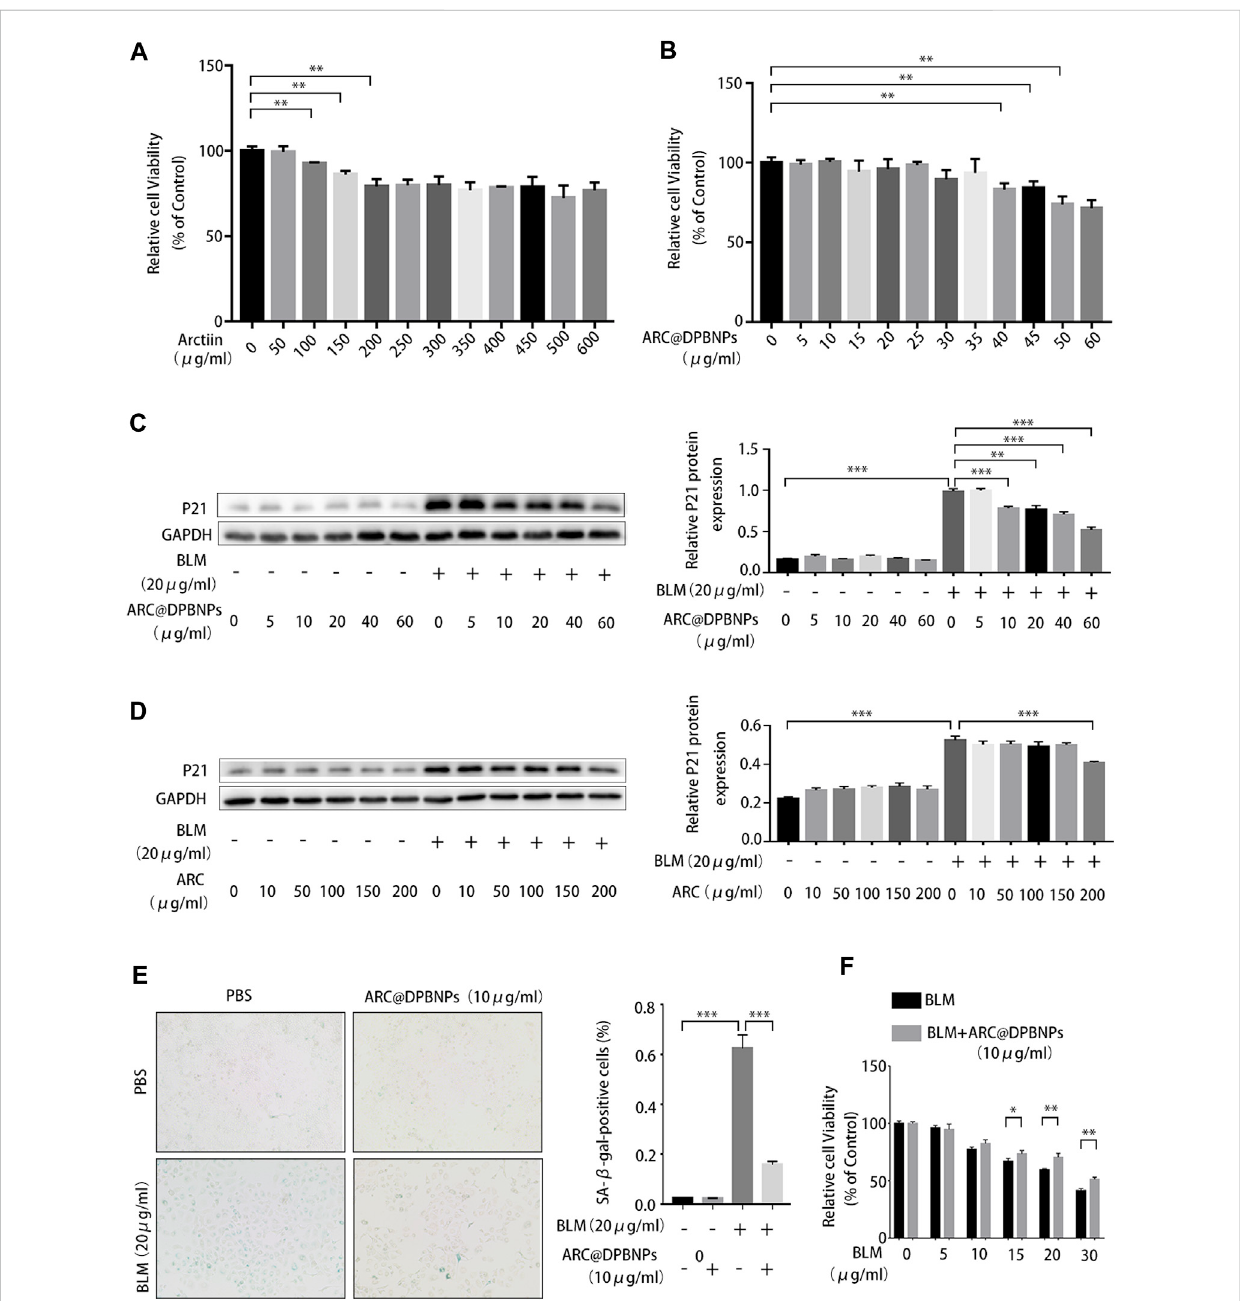
FIGURE 5 Arctiin (ARC)-encapsulated DSPE-PEG bubble-like nanoparticles (ARC@DPBNPs) inhibit A549 cell senescence induced by bleomycin (BLM) with lesseffectoncellvitalitycomparedtothearctiinmonomer (A,B) Cellcountingkit-8(CCK-8)assayswereperformedafterA549cellswerestimulatedwith ARC (0 – 600 μ g/mL) or ARC@DPBNPs (0 – 60 μ g/mL) for 72 h (C,D) ARC@DPBNP (0 – 60 μ g/mL) or ARC (0 – 600 μ g/mL) was used to cure A549 cell senescence induced by BLM. (E) Senescence-associated ß -galactosidase (SA- β -gal) staining was used to identify cellular senescence (original magni fi cation = ×200) (F) Decreased A549 proliferation stimulated with 20 μ g/mL or 30 μ g/mL bleomycin can be partially reversed by ARC@DPBNPs. * p < 0.05, ** p < 0.01, *** p <